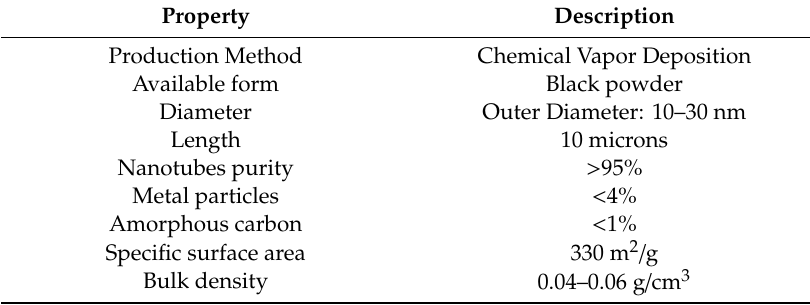
Table 2. Physical properties of MWCNTs. Source: Technical Data Sheet, provided with